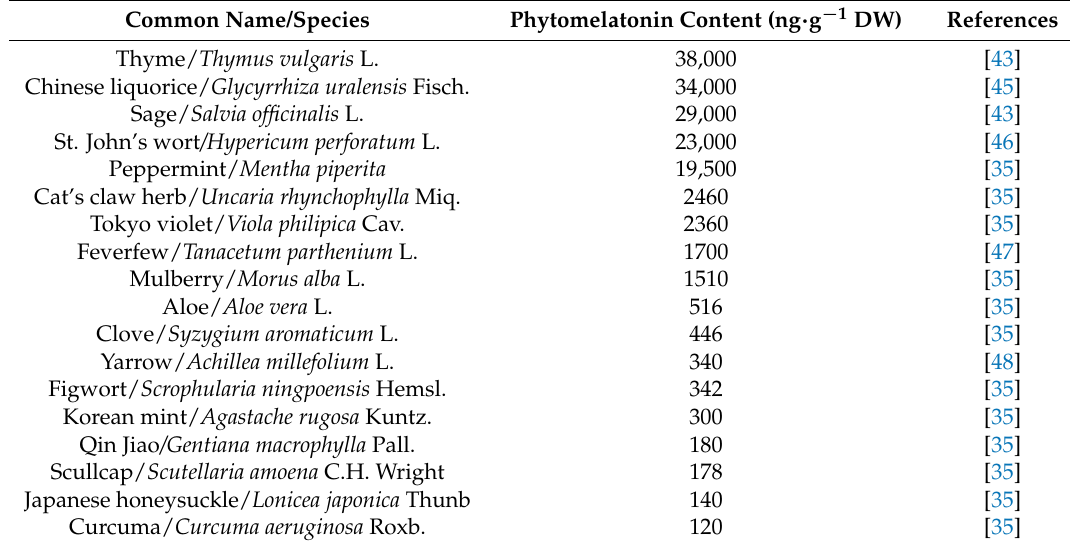
Table 2. Phytomelatonin content of some aromatic/medicinal plant